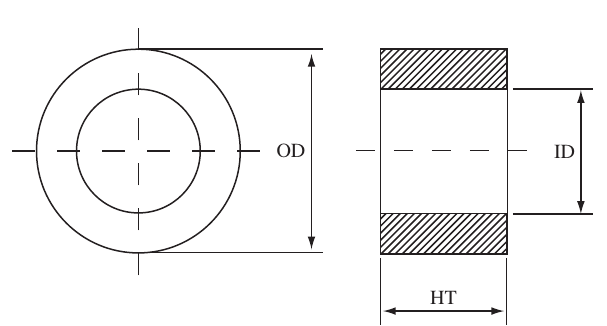
OD = Outer diameter ID = Inner diameter HT = Height Figure 3. Toroidal core